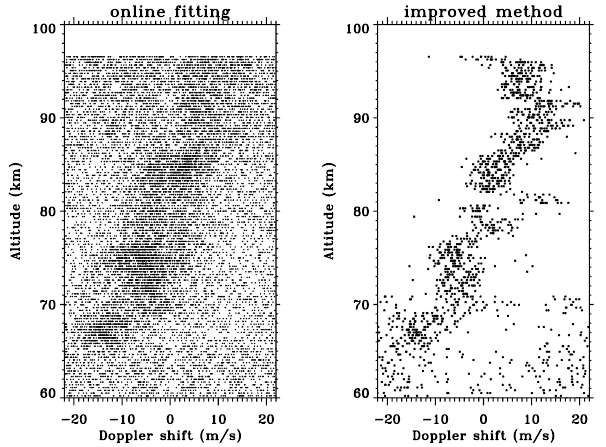
Fig. 5. The height range of parameter estimation in each month in 1997. Solid, dashed and chained lines correspond to the heights of successful estimation with on-line fitting (3 min resolution), the new method (3 min resolution), and the new method (30 min resolution),